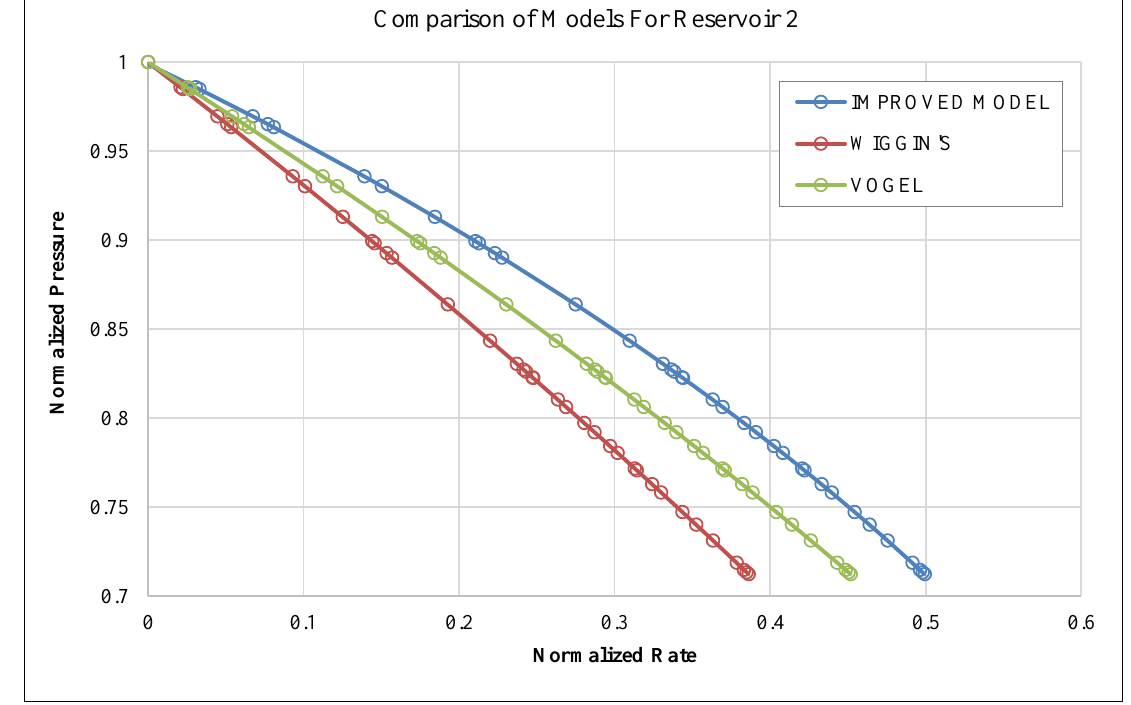
Figure 4. Plot of Normalized Pressure against Normalized Rate for Reservoir 2